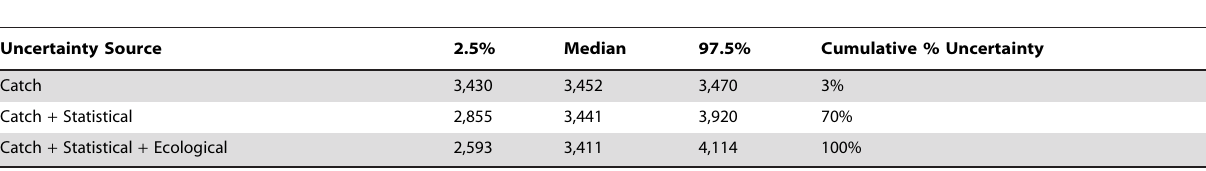
Table 6. Comparison of the sources of uncertainty in total ENP